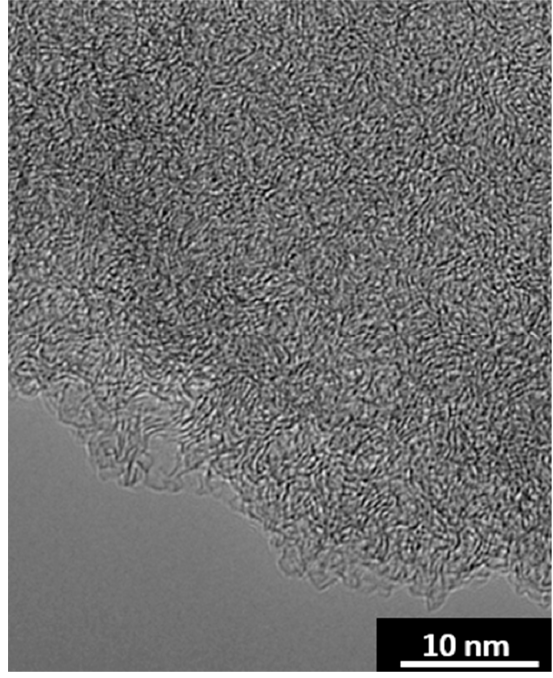
Figure 7. Sucrose char after heat treatment at 1200 °C for 5 s.